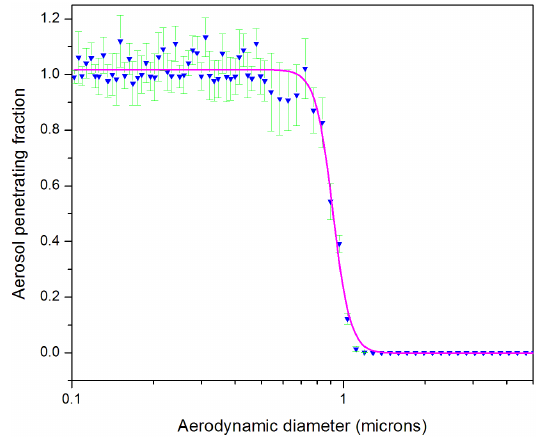
Fig. 2. Experimental determination of the water droplet survival line (water breakthrough) for different temperatures. Above the droplet survival line, the OPC can not distinguish ice crystals and water droplets.